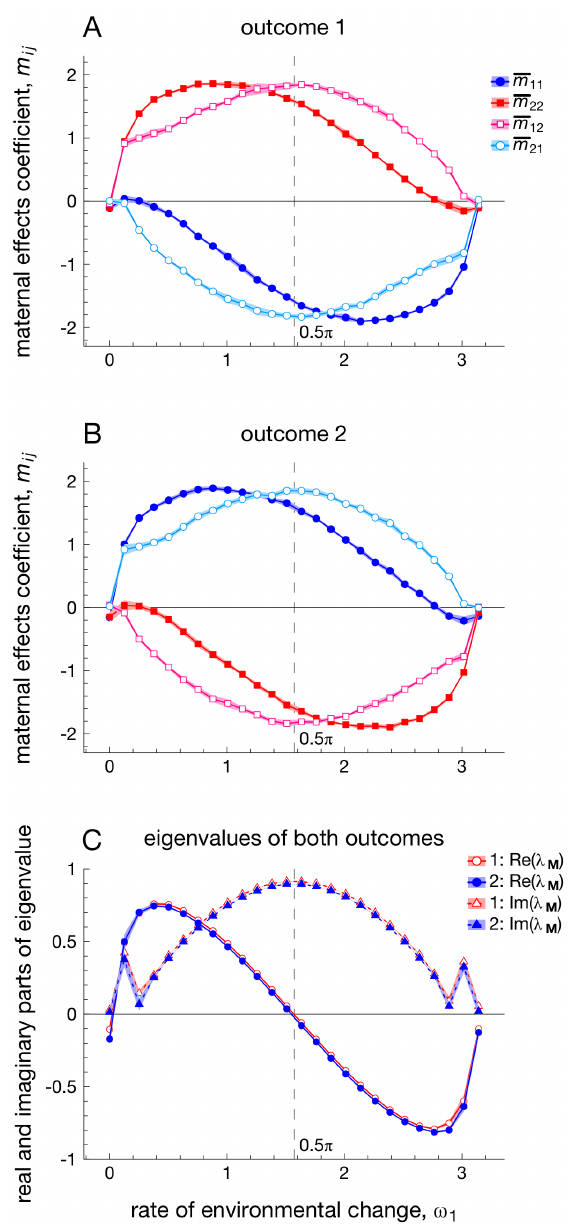
Figure 3. The evolution of multivariate maternal effects for different frequencies v 1 of environmental change, when periodically fluctuating selection is identical across traits (i.e., h 1 ( t )= h 2 ( t )). Panels A, B: entries of the multivariate maternal effects matrix M evolve towards two alternatively stable outcomes (outcome 1 and outcome 2). Panel C: real and imaginary parts of the eigenvalue l M of the maternal effects matrix are identical for both outcomes. For the sake of clarity, a value of 0.01 was subtracted from the eigenvalues of outcome 2, to prevent overlap with the eigenvalues in outcome 1. Each point in panels A and B depicts values of the maternal effect m ij ( t ) (at generation t ~ 50000 ) averaged over ten replicate generations, while shading depicts corresponding standard deviations. Parameters: m ~ 0 : 02, w ~ 0, c ~ 0, s e ~ 0 : 1 m 21 having positive values (with m 22 and m 12 being negative, Figure 3B).